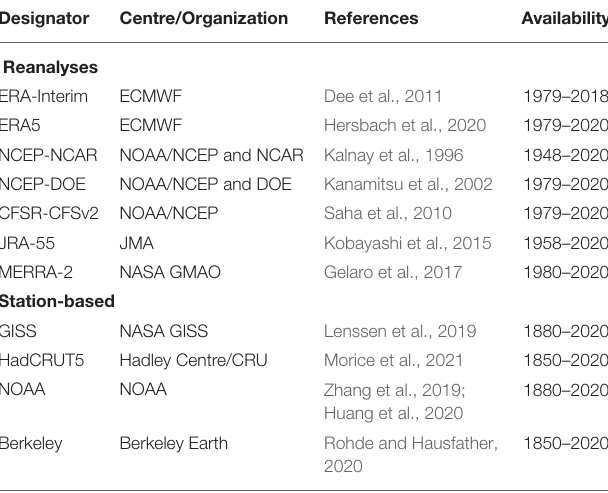
TABLE 1 | Reanalyses and station-based surface air temperature data.